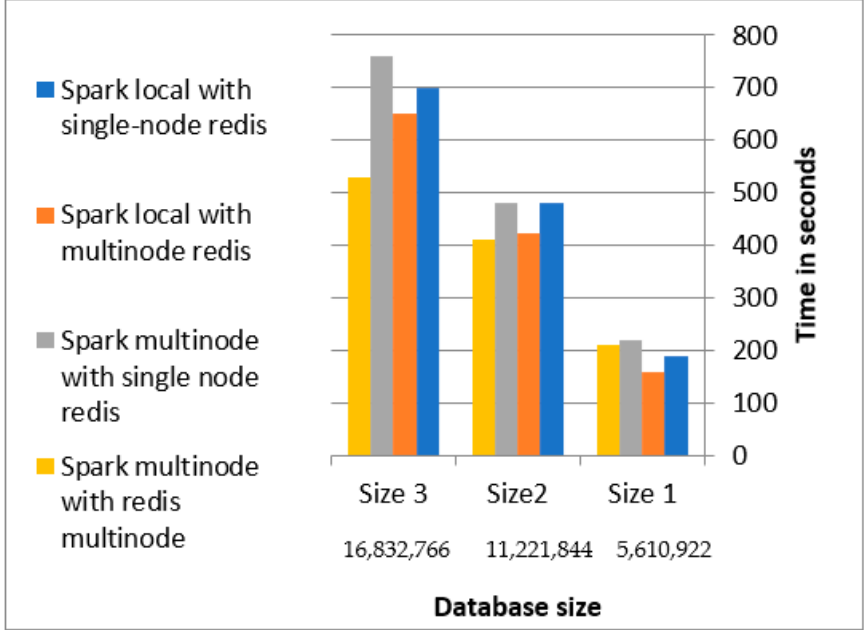
Figure 12. Elapsed time for migrating data to Redis using the proposed layer.